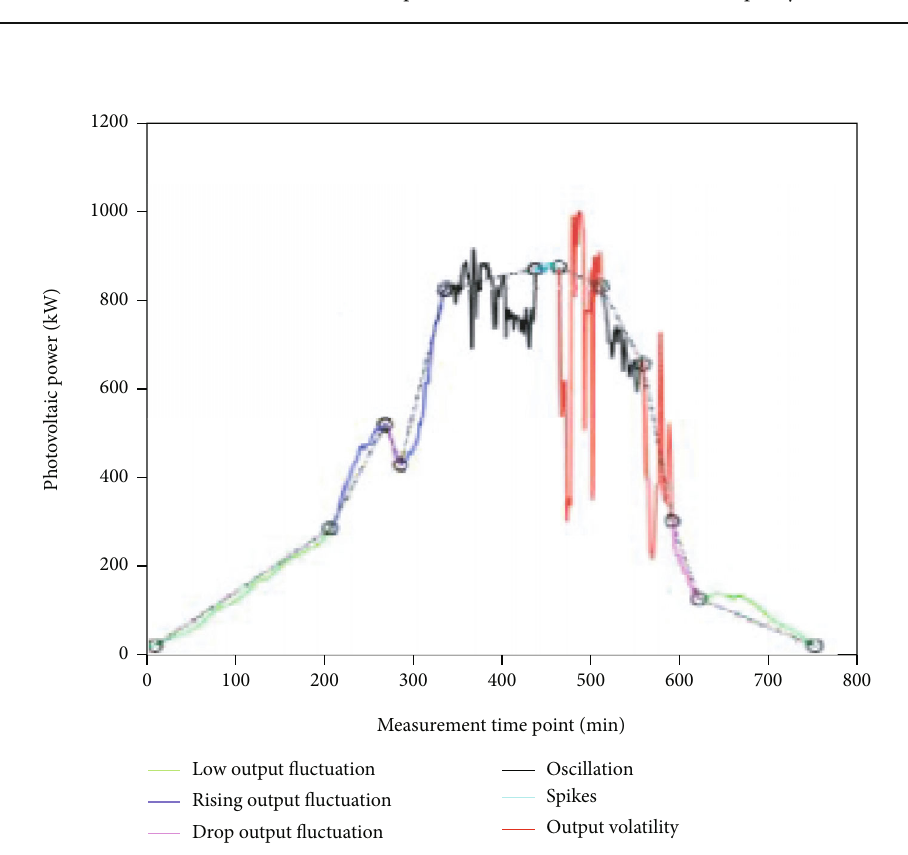
Figure 13: Comparison of the power fl